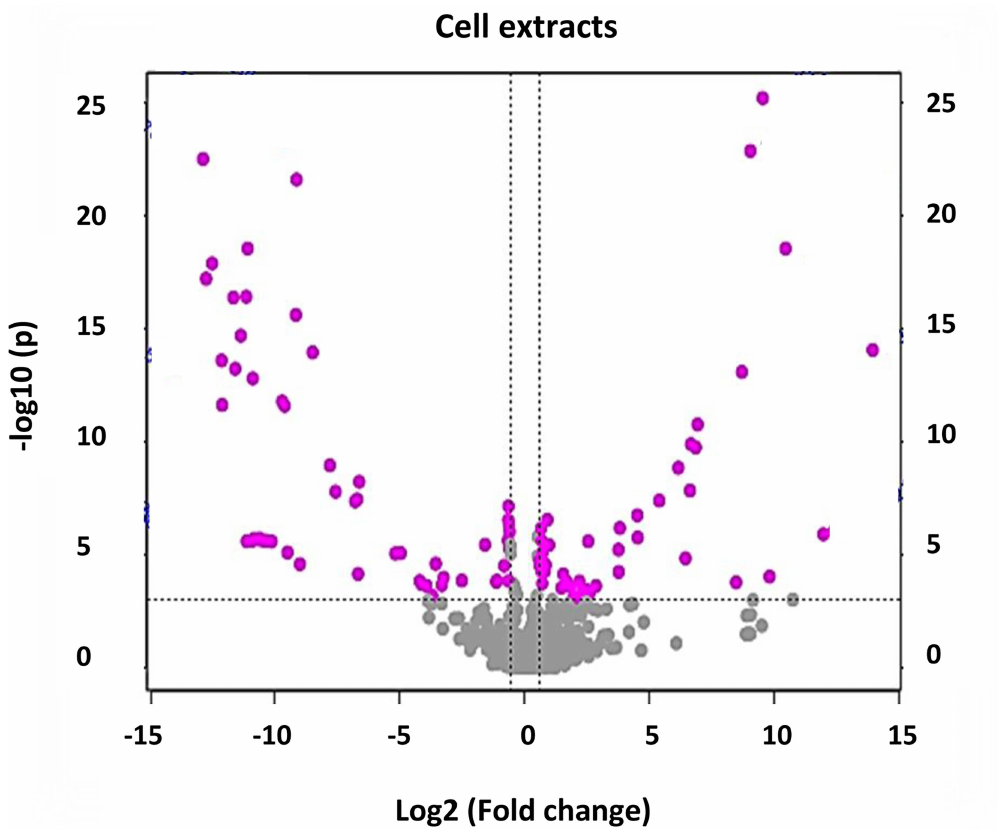
Fig 4. Volcano plot for identification of discriminating biomarkers. Analysis is based on the UHPLC- qTOF-MS (positive mode) time study of Arabidopsis cell extracts comparingcontrol versus samples treated with LPS for 24 h. The dashed line shown on the plot indicateswhere the p -value = 0.001, with ions above the line being statistically significant ( p < 0.001). Ions present in the left quadrant of the volcano plot are associated with the NT control and ions in the right quadrantare positively correlated to the treatment. The pink spots represent ions that have a fold changeof > 1.5. Ions situated towards the left and right top quadrants represent values of large magnitudefold changes as well as high statistical significance. The equivalentplot for the data obtained in negative mode is presented in Fig E in S2